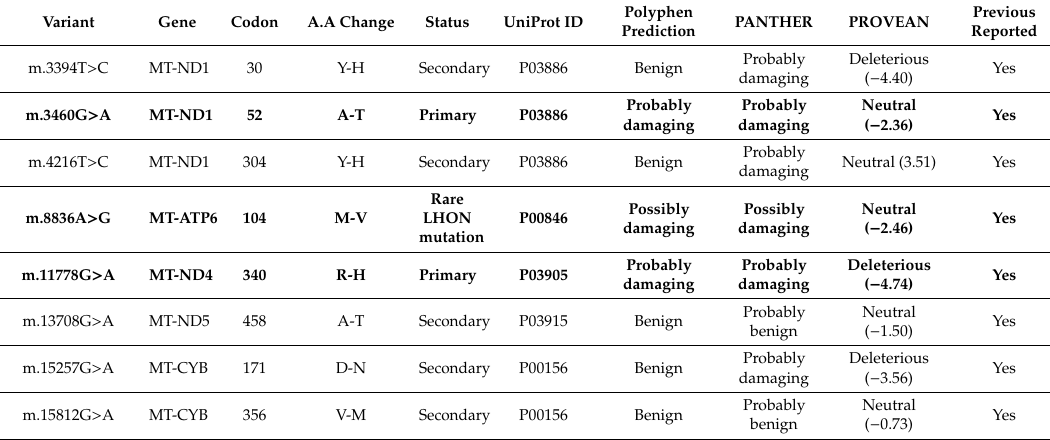
Table 2. In silico analysis of the pathogenicity of mtDNA mutations in Serbian LHON probands. Primary mutations are in bold; A.A change: amino acid change.